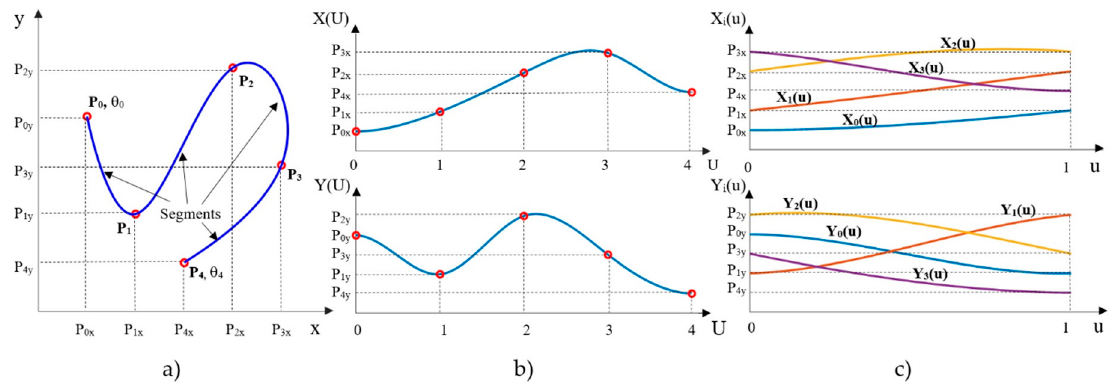
Figure 4. Cubic spline definition: ( a ) Cubic spline in cartesian space x-y, with five waypoints (orientation is imposed at start and goal points) and four segments, ( b ) parametric cubic splines for each coordinate of Cartesian space, X(U) and Y(U), ( c ) polynomials of each segment of the spline with normalized parameter u.